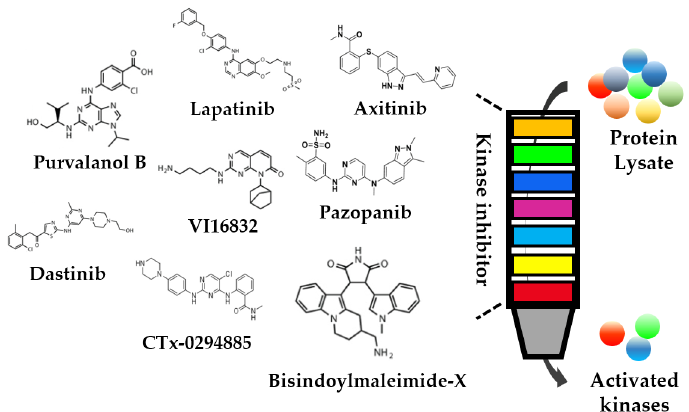
Figure 3. Workflow of kinome enrichment. Protein lysate is passed through an inhibitor conjugated beads column. The activated kinases are enriched and eluted in the